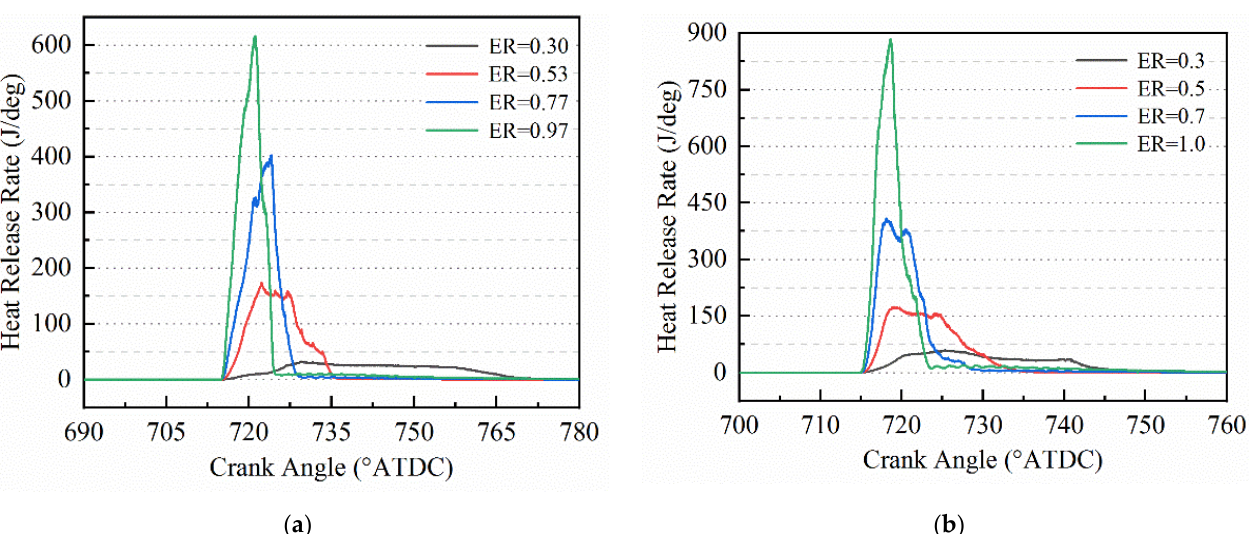
Figure 4. Heat-release rate curves for different equivalence ratios [48]. ( a ) CR = 12. ( b ) CR = 15.